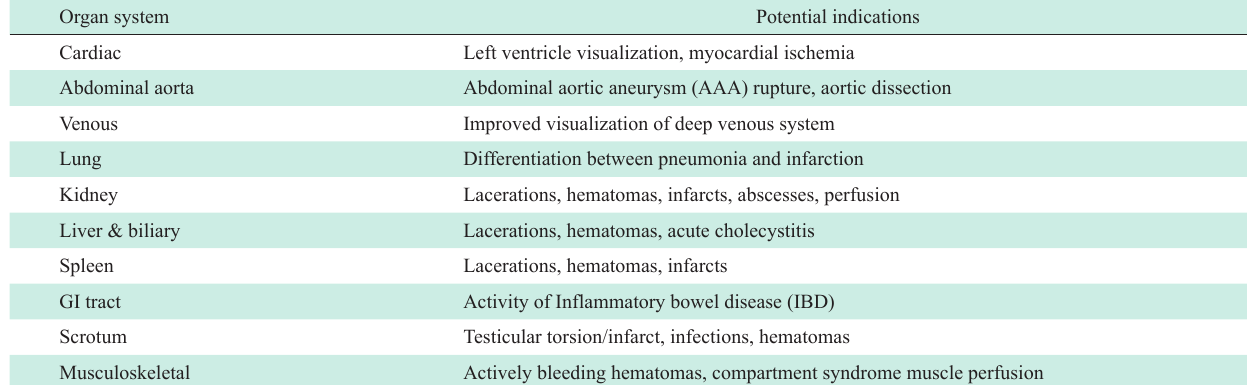
Table 2 Selected indications for point-of-care contrast medium-enhanced ultrasonography. Modified from [46]. Organ system Cardiac Abdominal